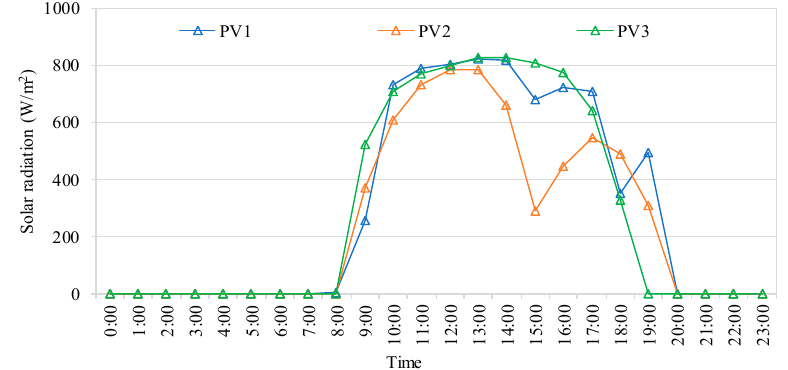
Figure A2. Solar radiation of the PV power station (source: POWERCHINA Kunming Engineering Corporation Ltd.).